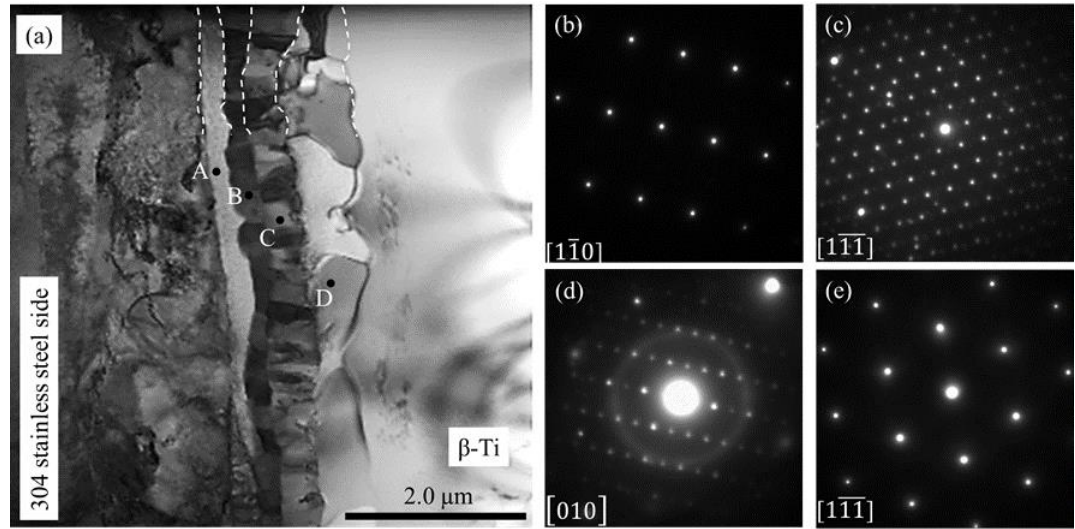
Figure 8. ( a ) Transmission electron microscopy bright field (TEM-BF) image of the joint interface. Selected area electron diffraction (SAED) patterns of layers ( b ) A, ( c ) B, ( d ) C, and ( e ) D.